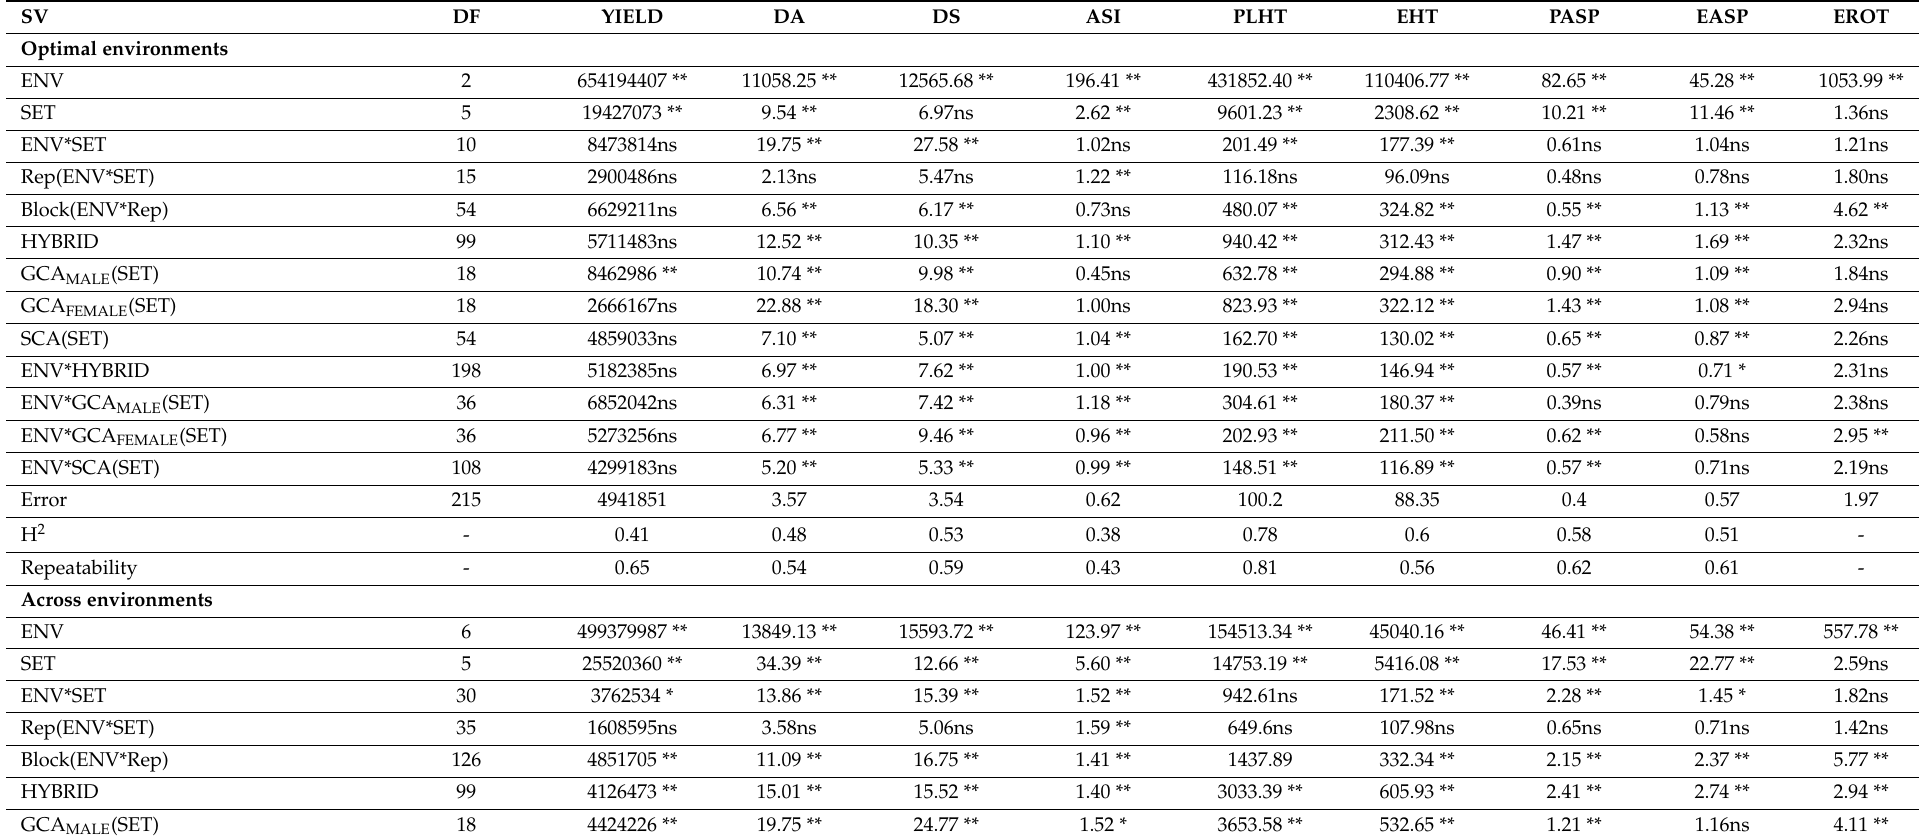
Table 2. Mean squares of grain yield and other agronomic traits of 96 early QPM hybrids evaluated under optimal conditions at Mokwa and Kadawa during 2019 and 2020 growing seasons and across test